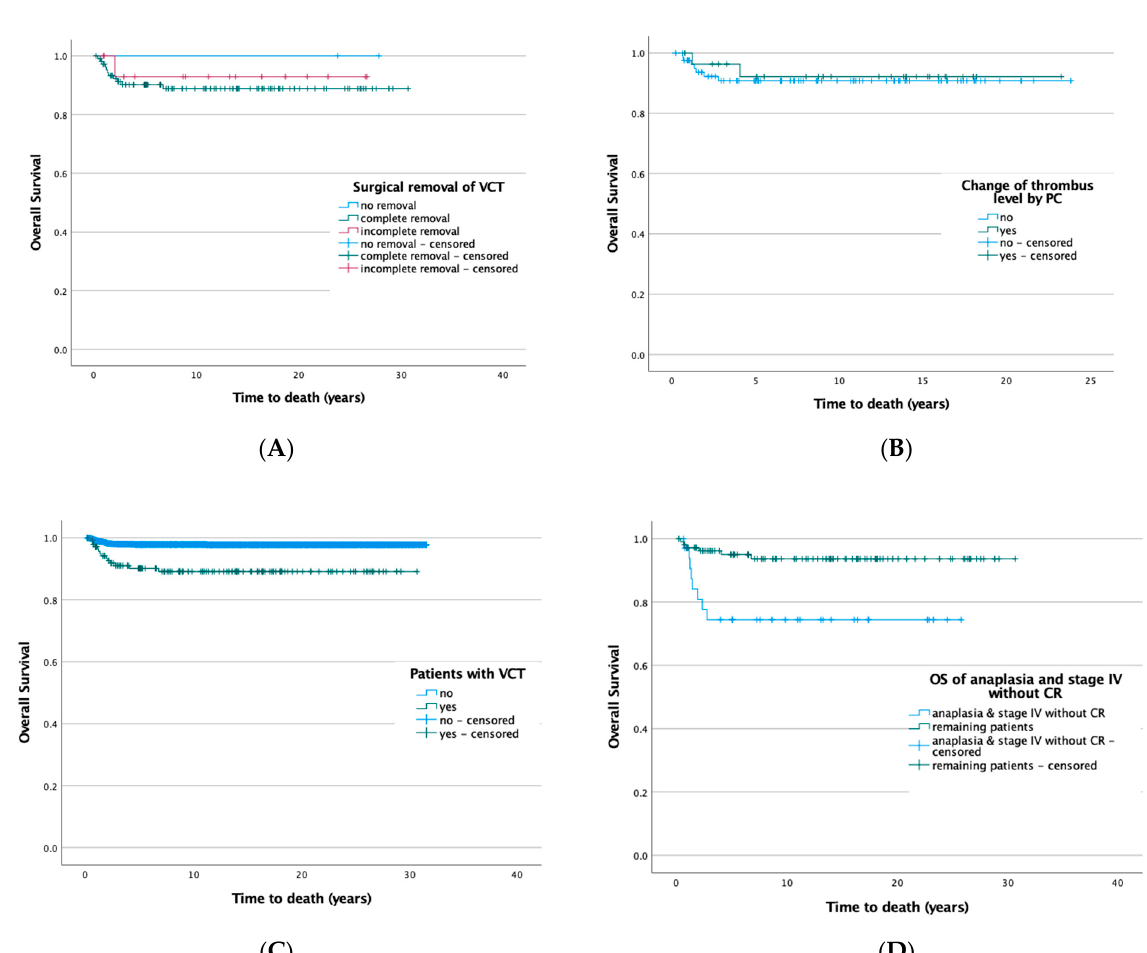
Figure 2. ( A ) OS by surgical approach (complete 89.8%, incomplete 93.8%, or no removal 100%, log rank: p = 0.794). ( B ) Influence of change in thrombus size on OS (yes 92.9%, no 91.6%, log rank: